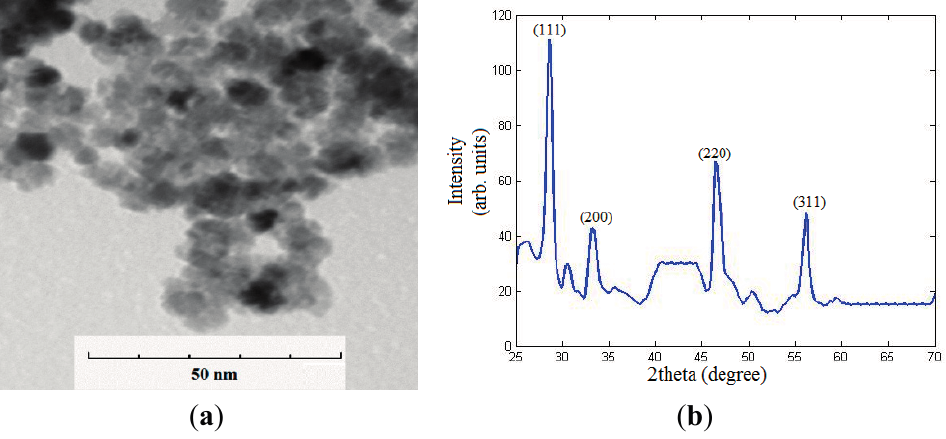
Figure 5. TEM image and XRD pattern of the synthesized ceria nanoparticles. ( a ) TEM image; ( b ) XRD